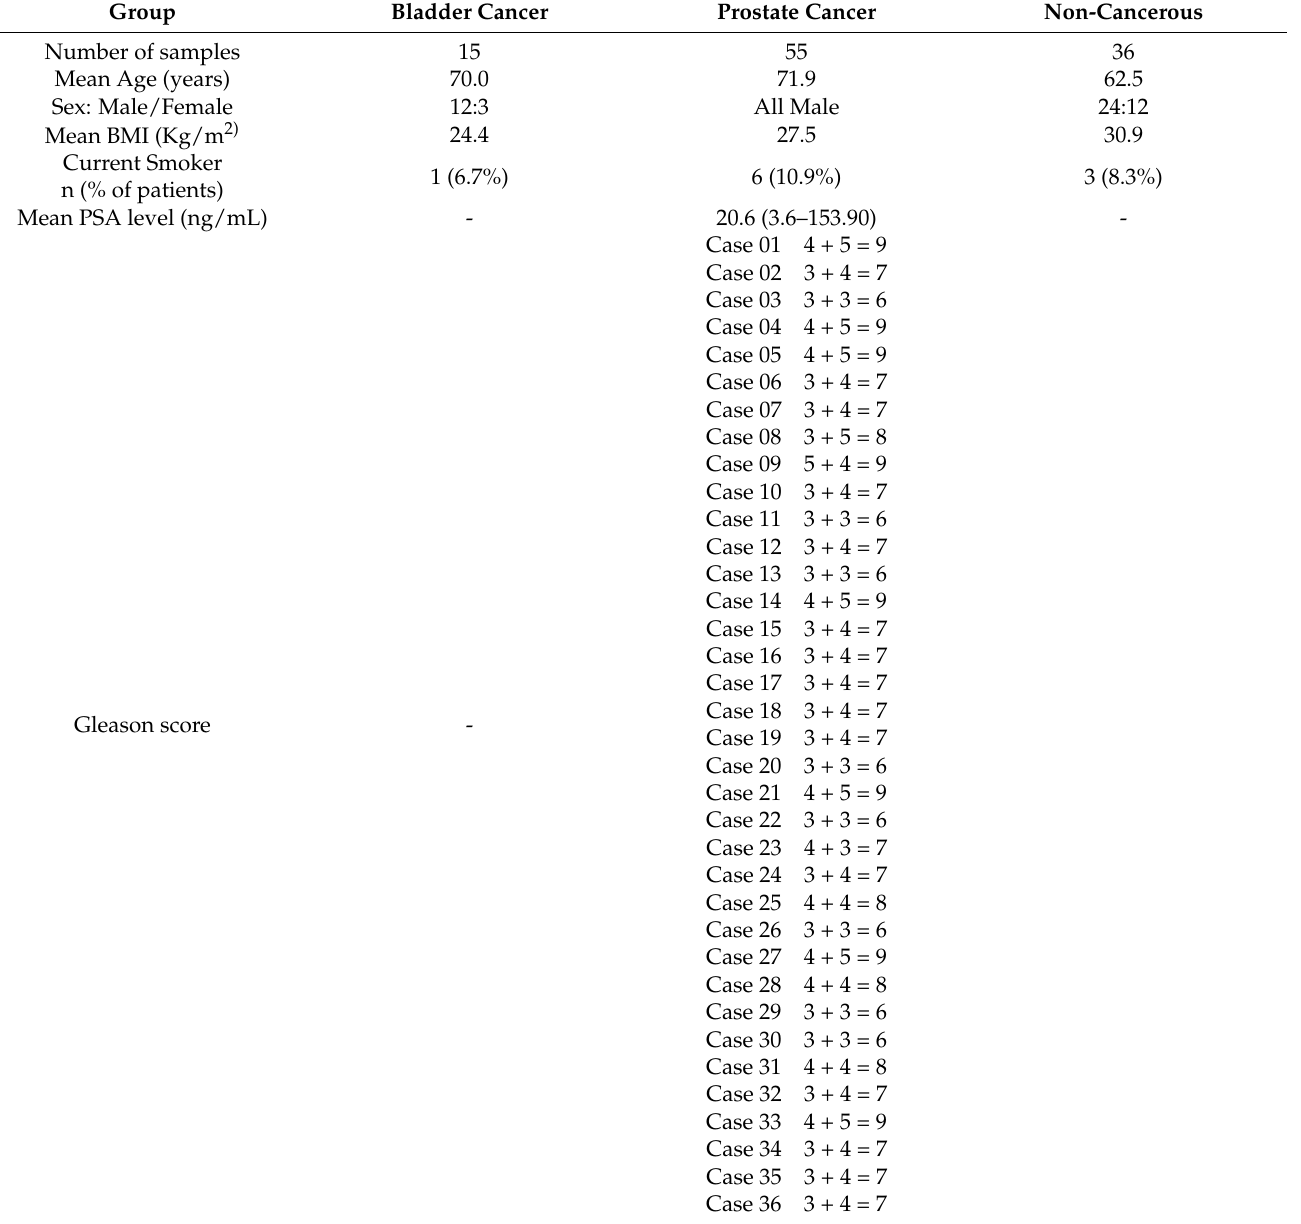
Table 1. Demographic data for subject